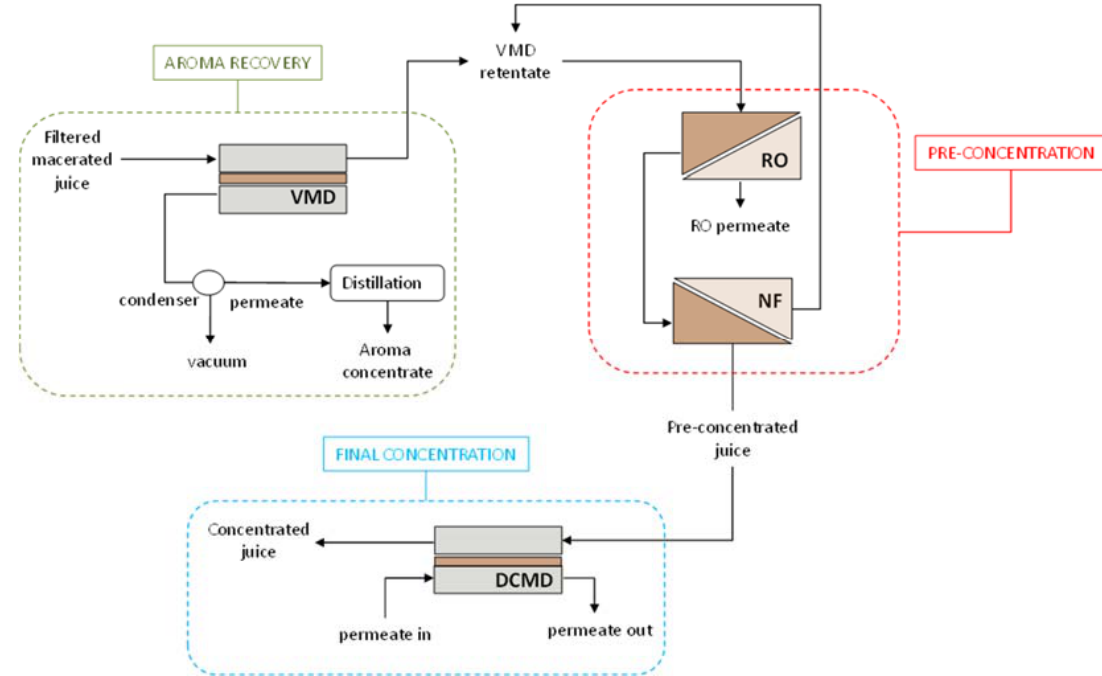
Figure 6. Process layout for aroma recovery and juice concentration based on membrane processes (adapted from [114]).